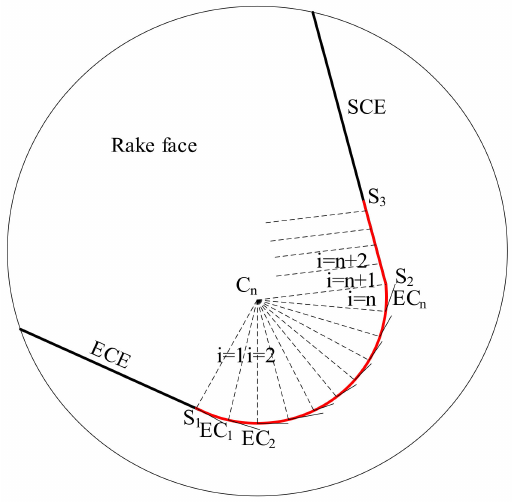
Figure 2. Diagrams of ACE and equivalent cutting edges.